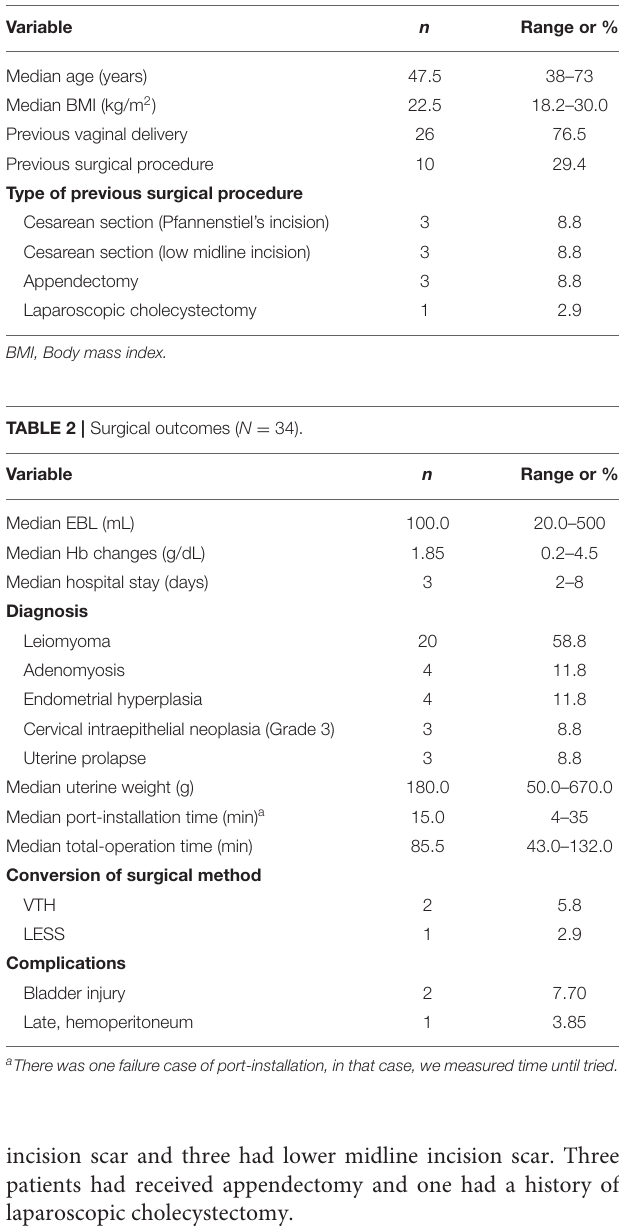
TABLE 1 | Patient characteristics ( N = 34).